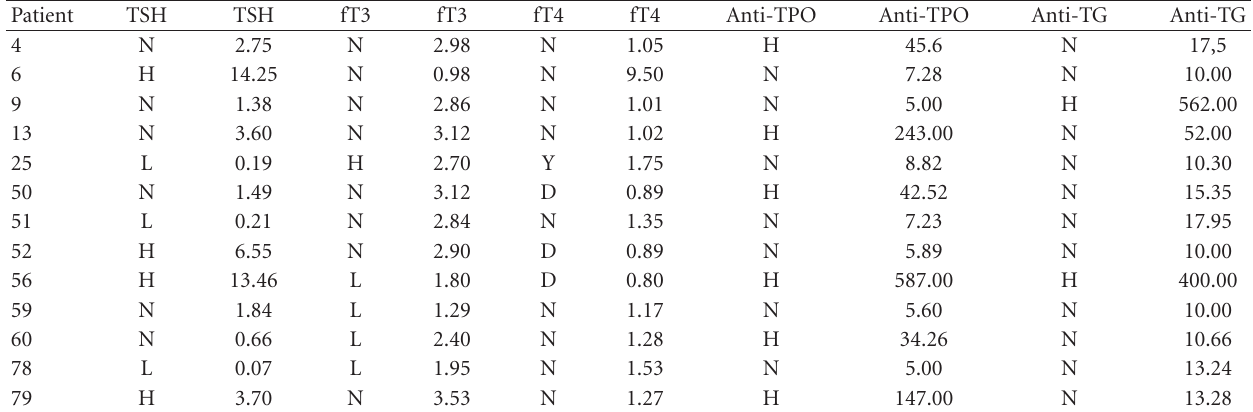
Table 2: Thyroid functions and anti-thyroid antibody levels in PV patients with thyroid disease.